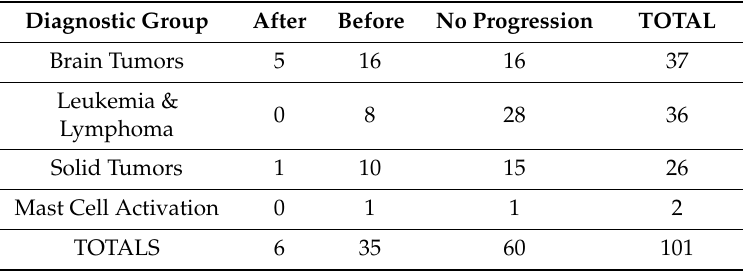
Table 1. Certification relative to disease progression.